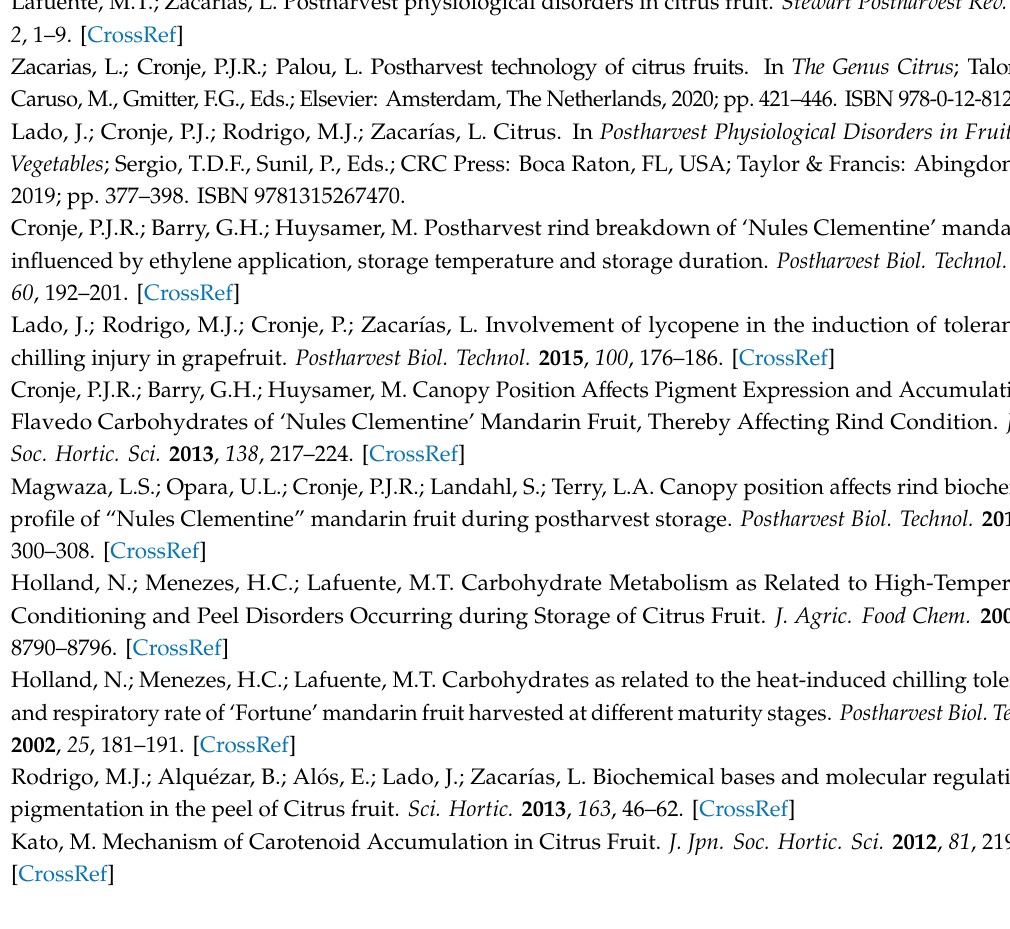
Figure S1: Pictures of the scale used to rate the severity of CI symptoms during postharvest cold storage; Figure S2: MaxPlot chromatogram of the saponified carotenoid extract of the Nadorcott flavedo at harvest; Figure S3: Chromatogram at 248 nm showing ascorbic acid peak; Figure S4: Pictures illustrating CI symptoms severity and magnification of CI development in fruit of Fortune, Nova, and Nadorcott; Table S1: Carotenoid limits of detection and working linear range; Table S2: Chromatographic and spectroscopic characteristics of carotenoids found in the flavedo of the three mandarin